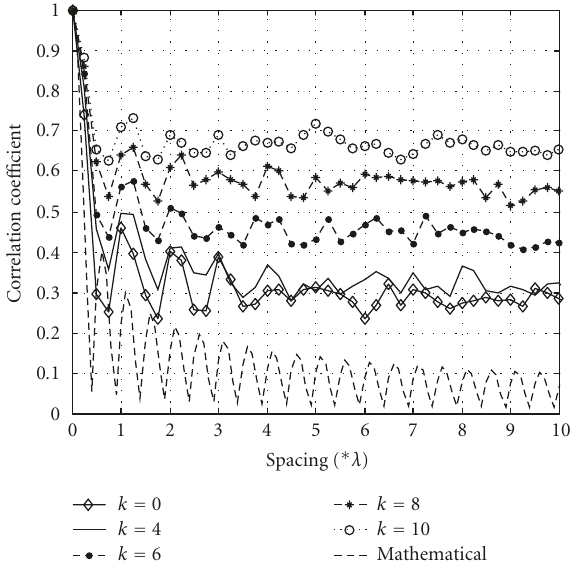
Figure 3: Antenna correlation versus spacing for sample line of sight strengths, with ground